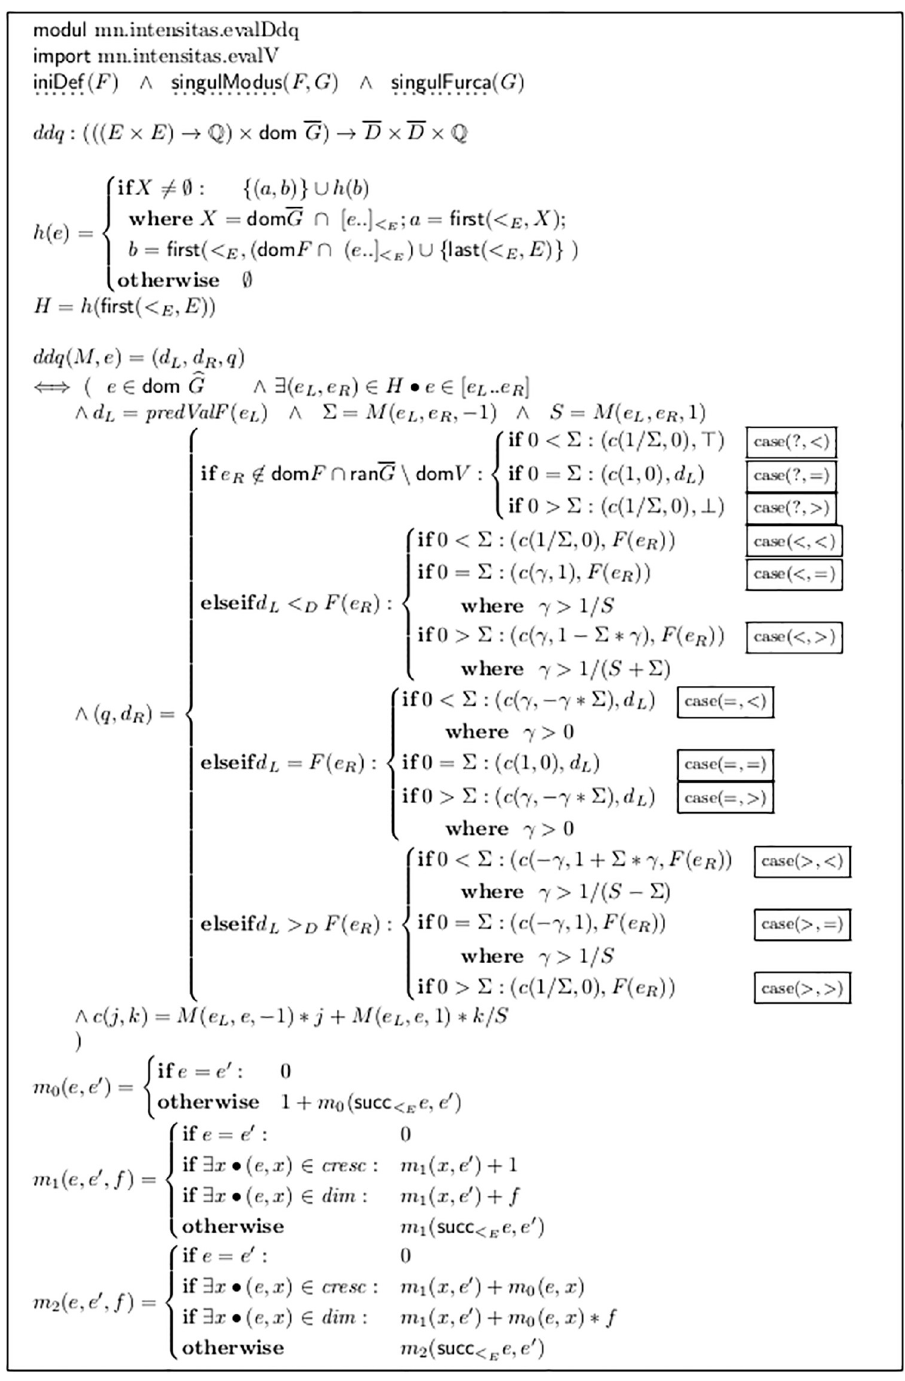
Fig 16. DDQ-analysis for inter- and extrapolating of fork groups.